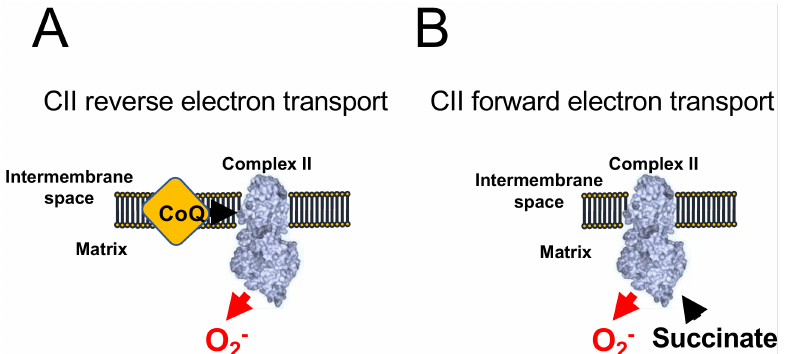
Figure 3. ROS production by Complex II. CII-dependent ROS production has been shown to occur only when CI and CIII are blocked. ( A ) When CoQ is highly reduced CII generates atpenin A5- sensitive ROS in its reverse reaction. ( B ) The accumulation of succinate promotes malonate-sensitive ROS in its forward reaction. To note, ROS production triggered by oxidation of G3P can also be promoted by other sources, such as CI (RET) and, more scarcely, CIII o [23,49]. In very specific experimental